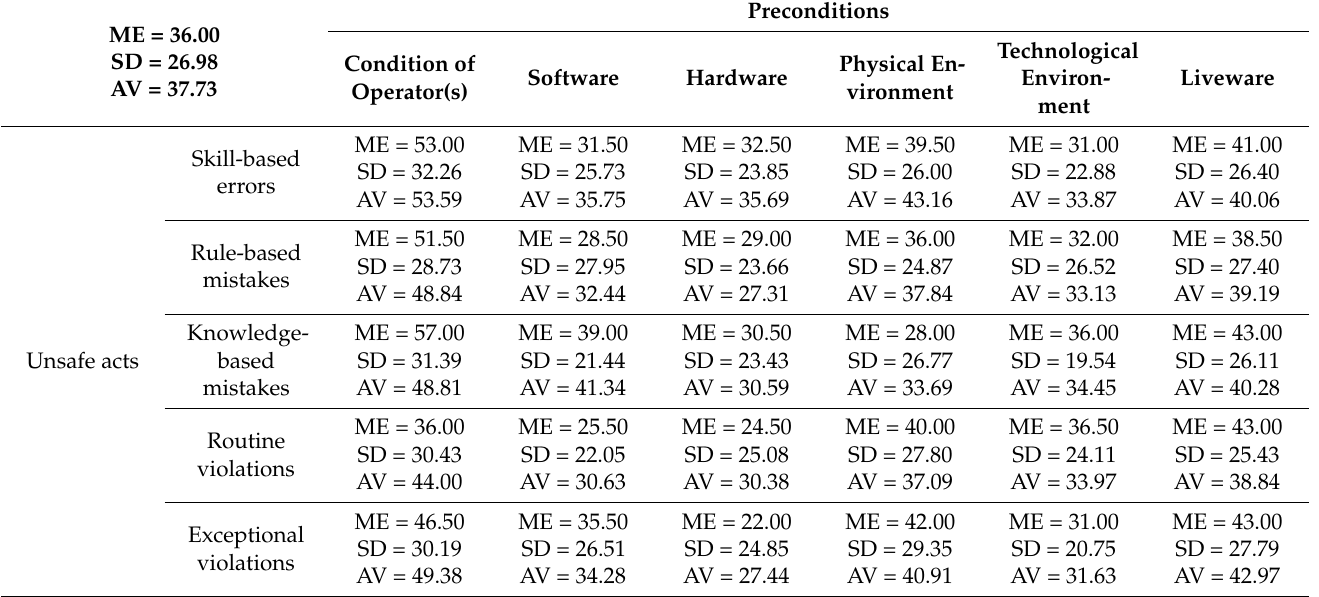
Table A4. Median (ME), standard deviation (SD), and average (AV) for responses on Stage 4 (how Preconditions affect the occurrence of Unsafe